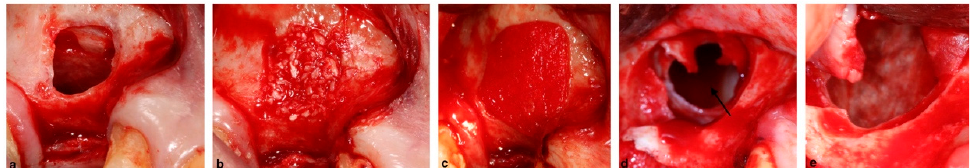
Figure 8. Use of resorbable membranes in SFA procedures: ( a ) SFA procedure lateral window access for membrane elevation, ( b ) freeze dried bone allograft in place after the membrane elevation, ( c ) SFA window covered with resorbable collagen membrane after bone graft placement, ( d ) Schneiderian membrane perforation during an SFA procedure (indicated by arrow), and ( e ) Schneiderian membrane perforation repaired with resorbable collagen membrane.